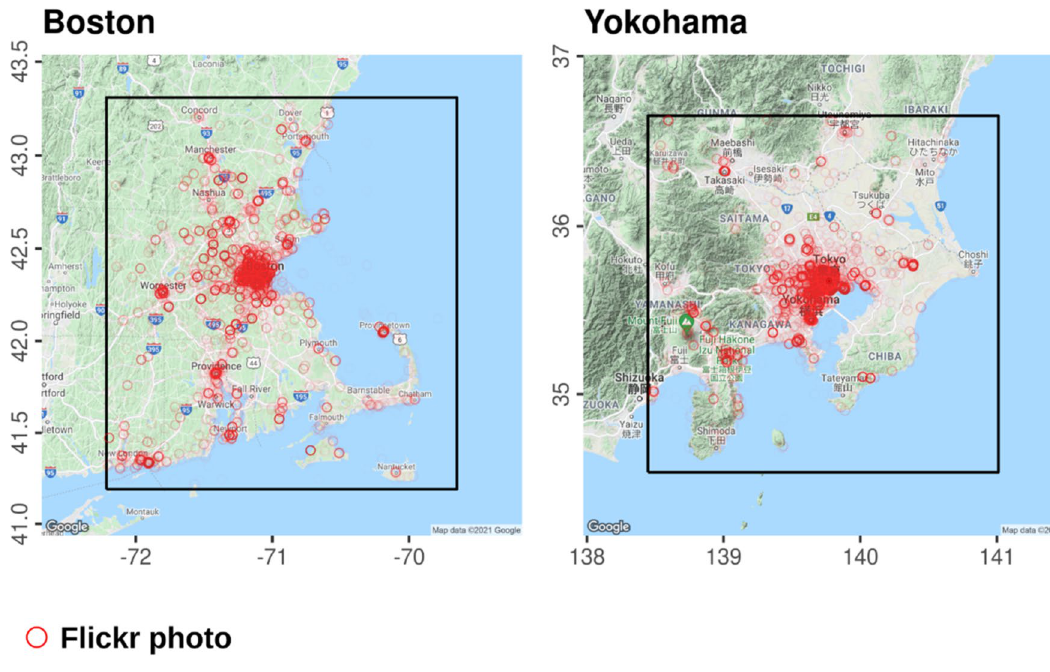
Figure 1. The Boston and Yokohama study areas. Circles mark the locations of analyzed Flickr photos that include human faces (N = 62,642 in Boston; N = 74,619 in